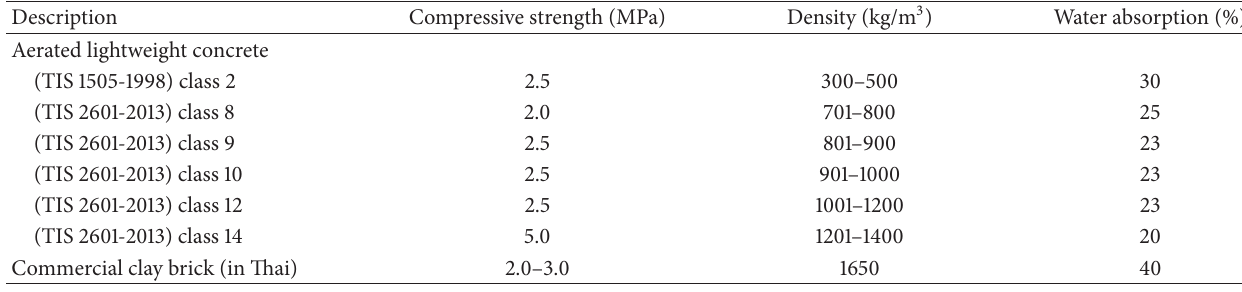
Table 4: Comparison between cellular concrete and other materials.